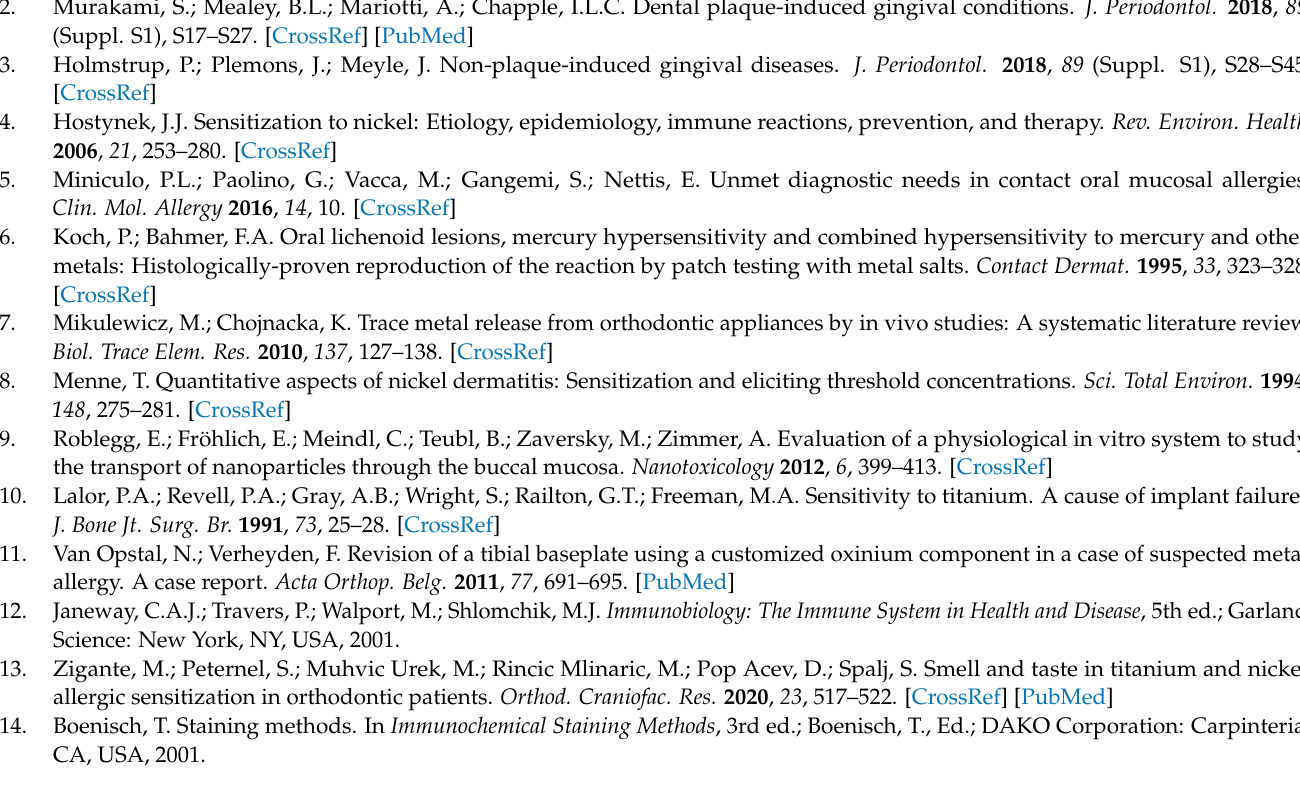
B-lymphocytes in non-sensitised patient (Expression of CD20 molecule (B-lymphocytes) is in brown.; Figure S5: Example sample of immuno-staining for plasma cells in non-sensitised patient (Expression of CD138 molecule (plasma cells) is in